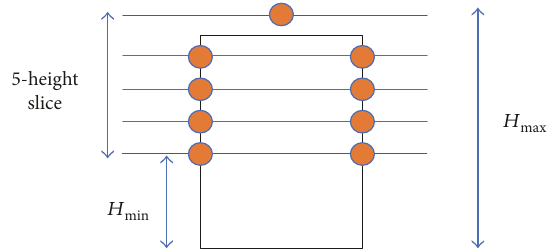
Figure 2: Roadmap creation for a single obstacle: side view of k - division on a single